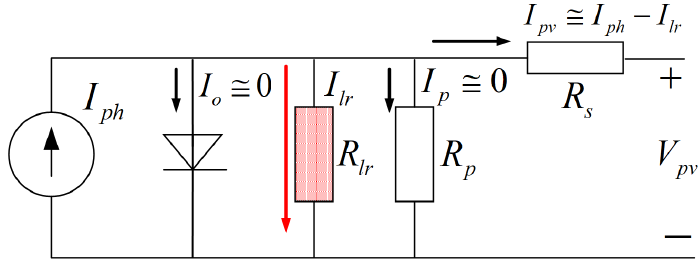
Figure 4. Simplified model of a hotspot defected cell.